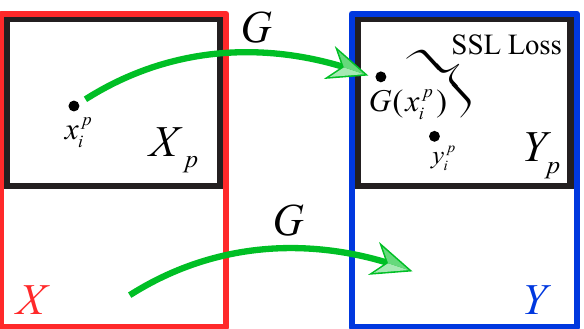
= G ( x p ) i i ) | i = 1, . . . , M } , y p SSL i i